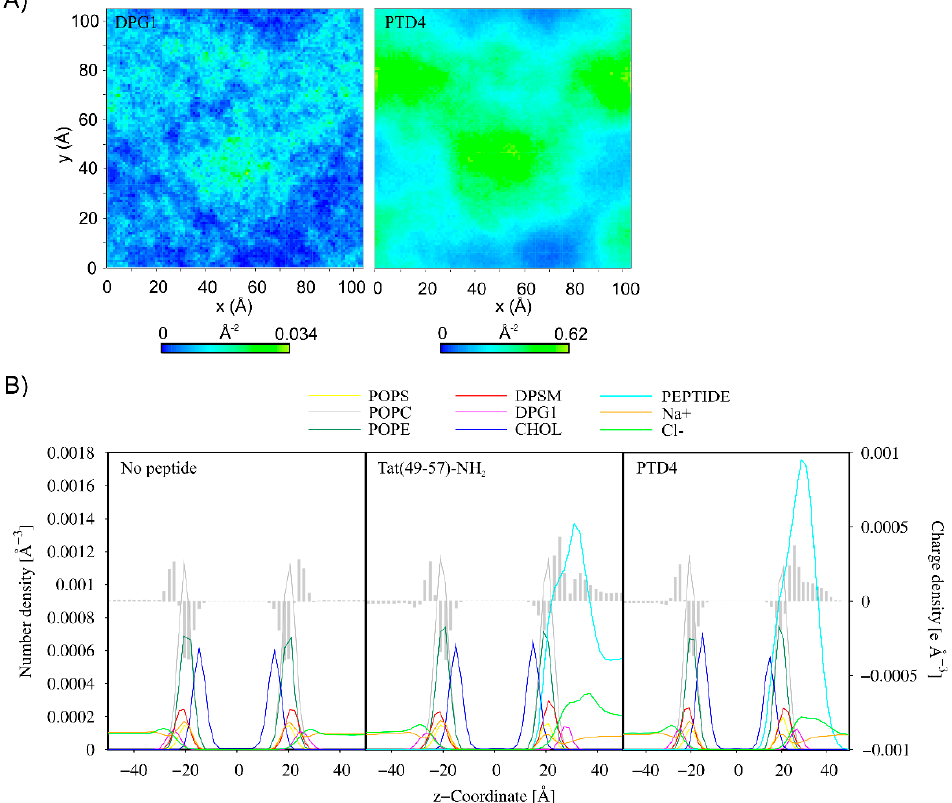
Figure 5. ( A ) 2D density map of DPG1 lipids and PTD4 in the upper leaflet of the membrane. The grid spacing was set to 1 Å. The last 1 µ s of 10- µ s CG MD simulations was considered for the analysis. ( B ) Partial density and charge density profiles averaged over the last 1 µ s of MD CG simulations of the systems without peptide and with multiple Tat(49–57)-NH 2 and PTD4 molecules.